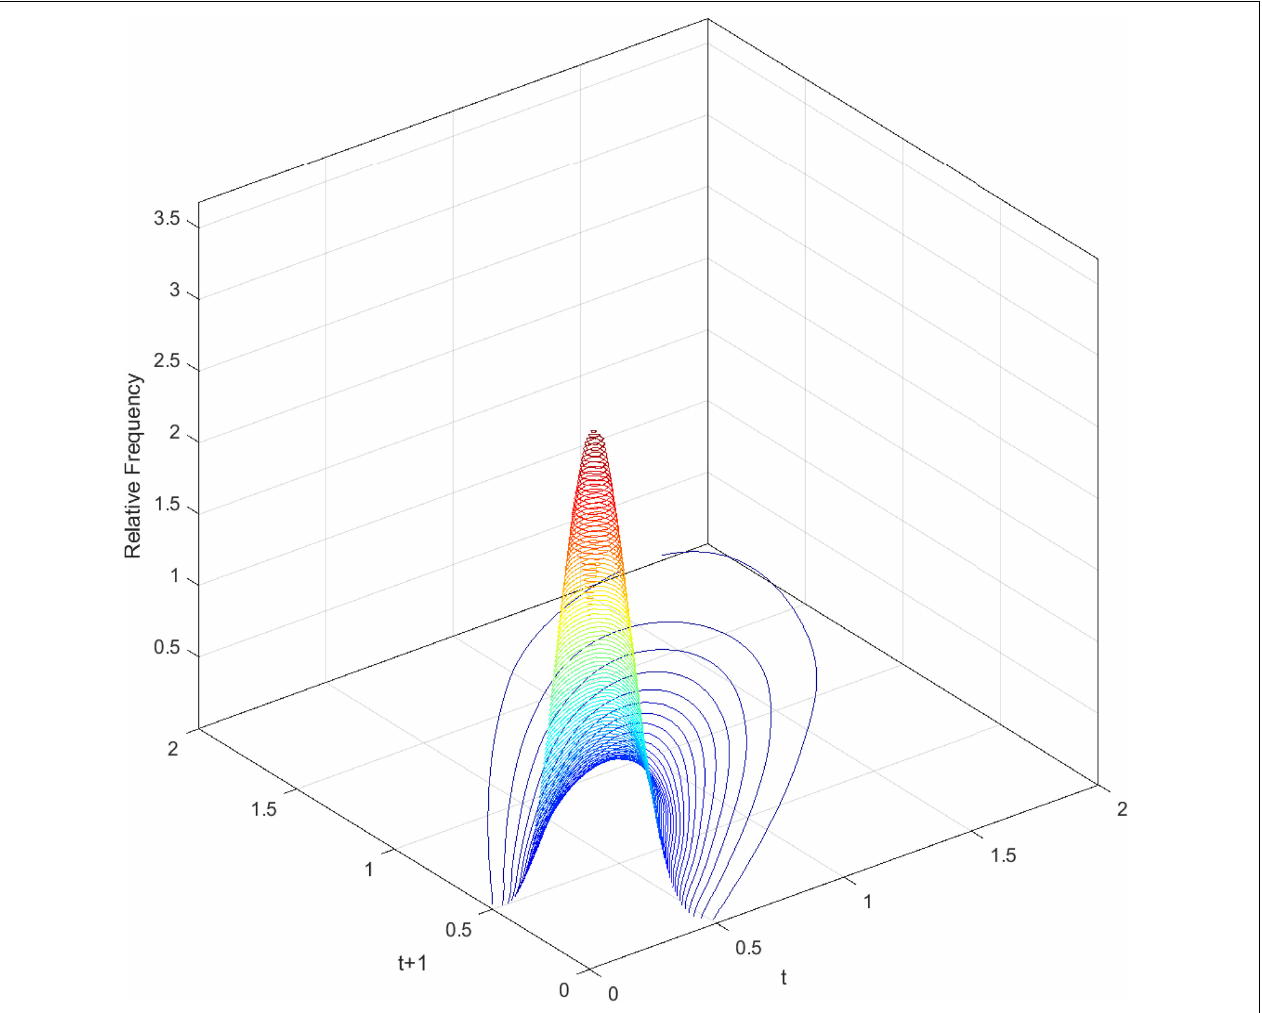
FIGURE 3 | Three-dimensional plot of transition probability kernel for the relative RSVAPC of all countries with annual transitions. Source: Authors’ calculation.